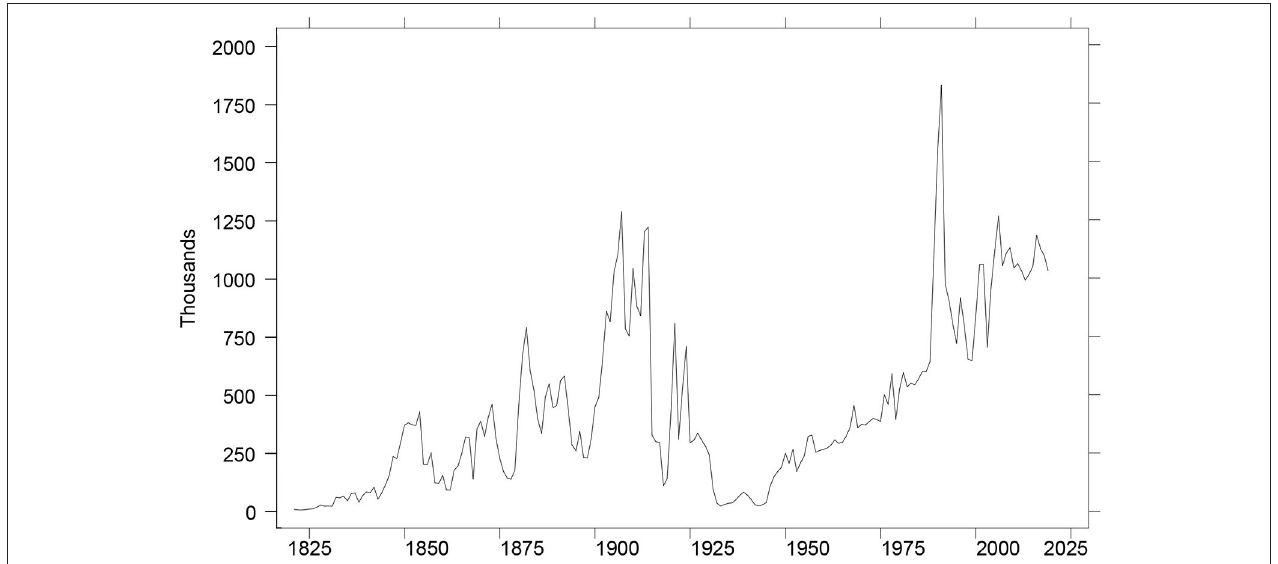
FIGURE 1 | Immigration to the United States: 1820-2019. Annual totals represent the number of persons admitted to legal permanent residence (U.S. Department of Homeland Security, 2019, Table